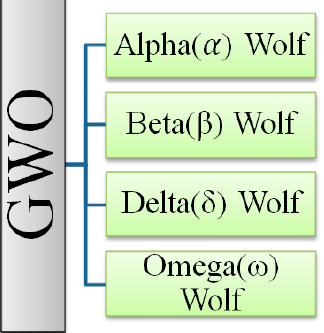
Figure 2. Hierarchy of the gray wolves (GW)